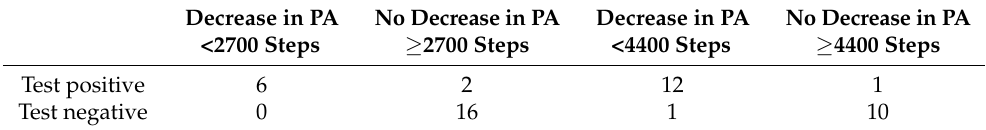
Table 4. Contingency table of the gait pattern.